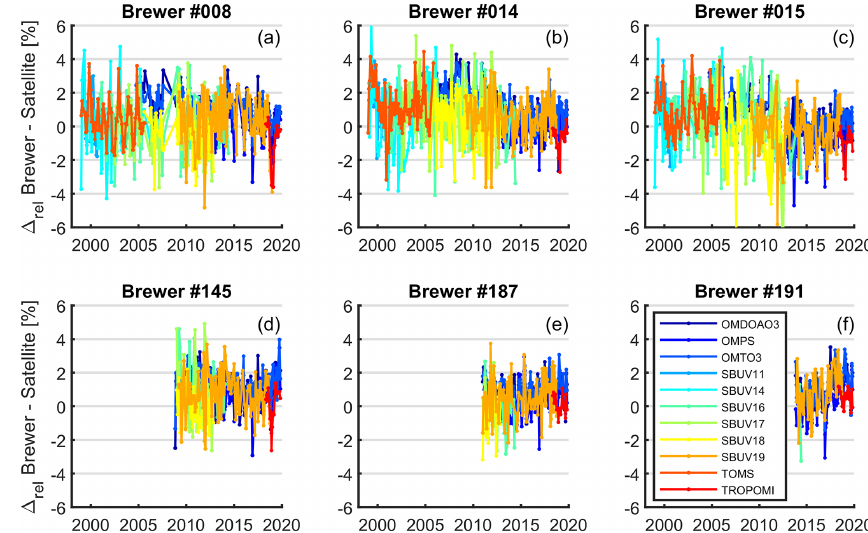
Figure 6. The relative difference between satellites and the world Brewer reference triads (BrT and BrT-D). Each point represents a 3-month average. Brewers and satellite data are paired with the criteria shown in Table